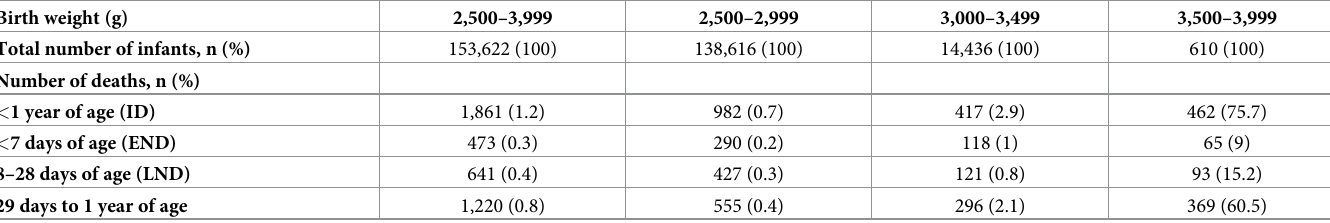
Table 3. Relationship between early neonatal death/neonatal death and birth weight (2500–3999 g).